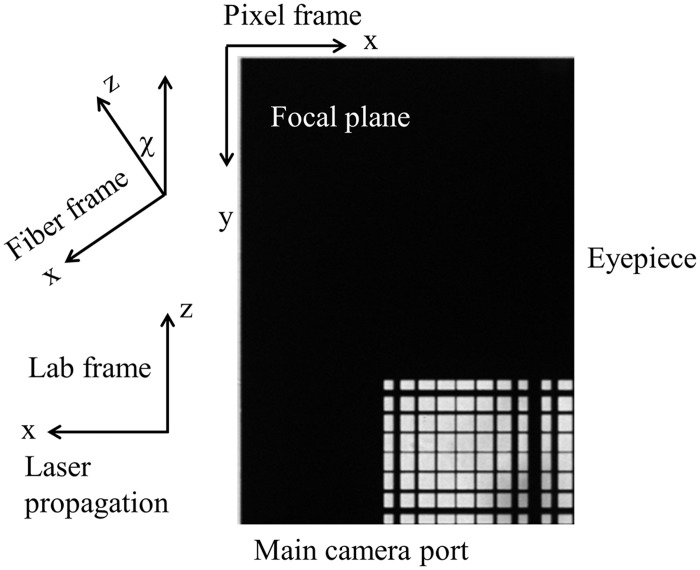
The fiber frame xz plane in Fig 1 lies in the microscope focal plane and in the lab frame as shown.Lab and fiber frames are related to each other by a rotation through χ. Images of the heart shown subsequently relate to the lab frame like the image of the test pattern.